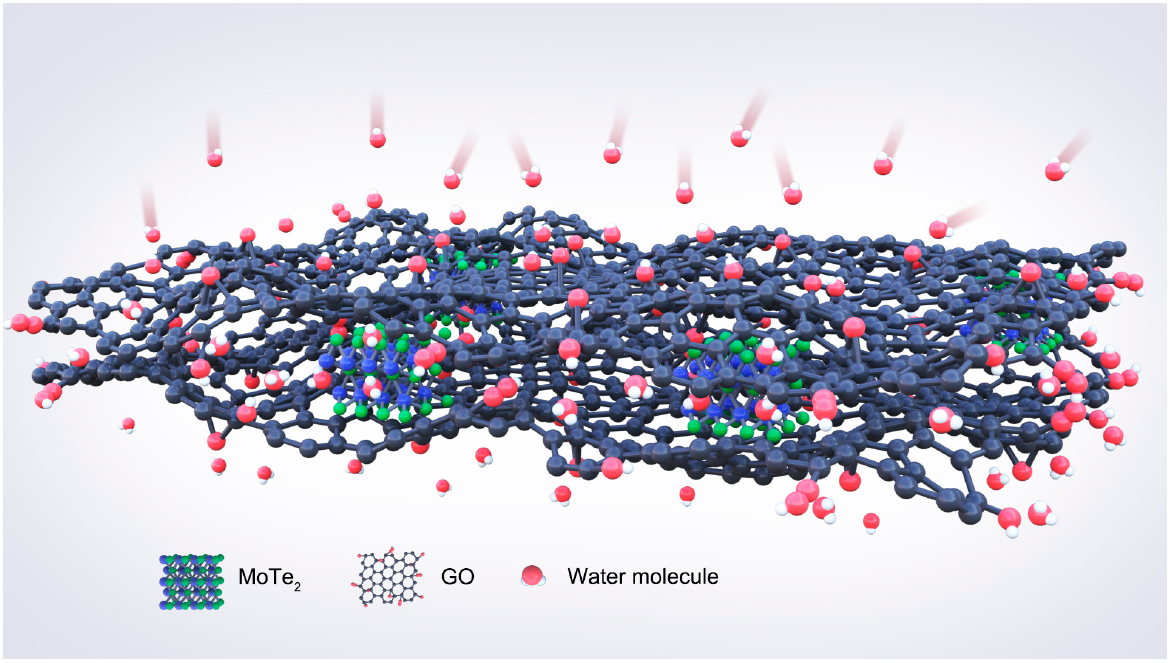
Figure 9. The humidity sensing mechanism schematic diagram of the sensor.